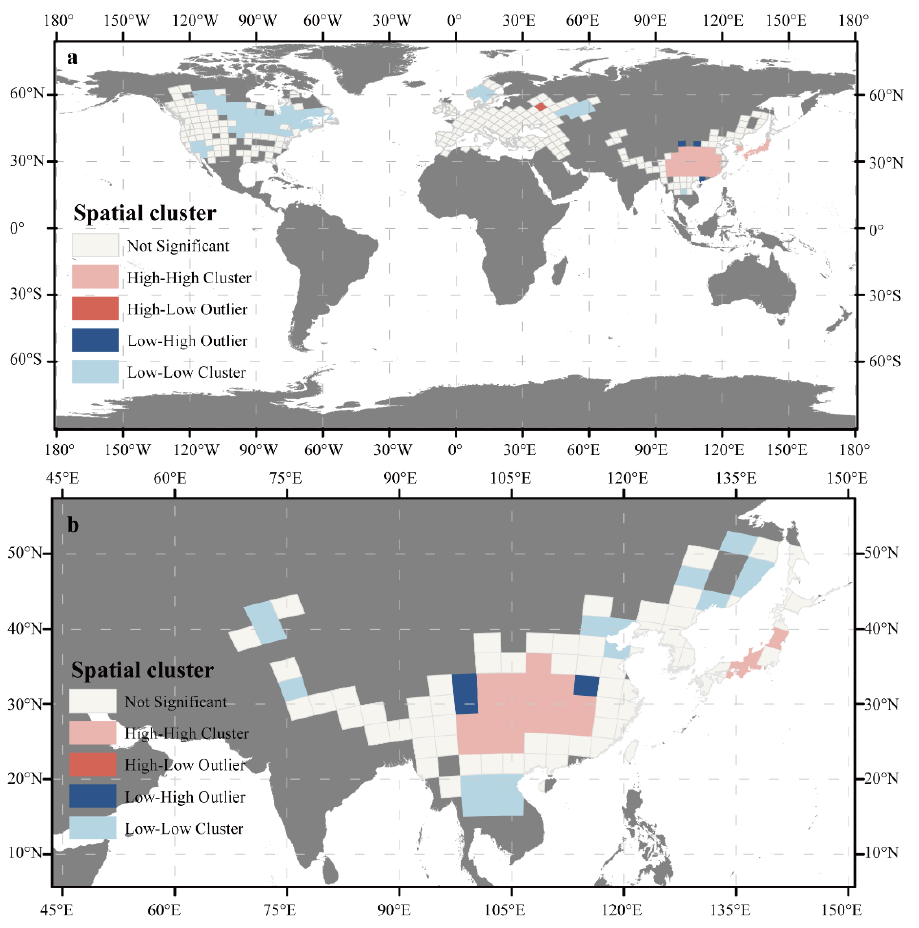
Figure 3. ( a ) Clustering the geographical distribution of species richness at the global scale. ( b ) Clustering the geographical distribution of the species richness of eastern Asia. High–high cluster means a high value for itself and a correspondingly high value for the adjacent areas; high–low outlier means a high value for itself and a low value for the adjacent areas; low–high outlier means a low value for itself and a high value for the adjacent areas; low–low cluster means a low value for itself and a correspondingly low value for the adjacent